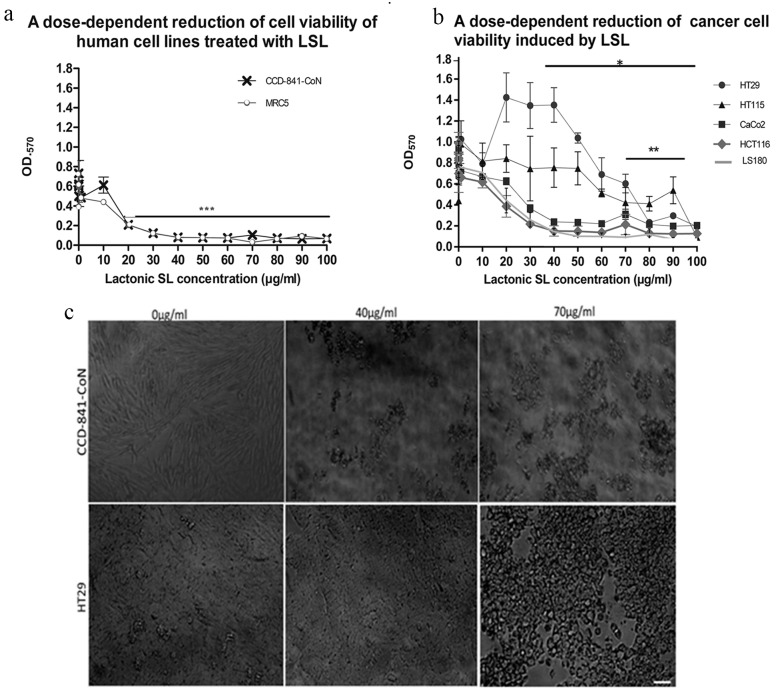
LSL administration causes a dose-dependent effect on cell viability and morphology.(a) Following 24h of treatment with LSL we observed a significant reduction in O.D.570 values at doses between 20–100μg/ml (p<0.0001) in the control cell lines CCD-841-CoN and MRC5. (b) There was a significant reduction in O.D.570 values at doses between 30–100μg/ml in HCT116, Caco2 and LS180 (p < 0.05) and at doses above 60μg/ml inn HT29 and HT115 cells (p < 0.001). Graphs show a representative data set from three independent experimental replicates. Values indicate mean ± SEM (n = 6). Statistical significance was assessed one-way ANOVA (*p < 0.05; **p < 0.001; ***p < 0.0001). (c) Light micrographs from CCD-841-CoN colonic epithelial cells (top) treated with vehicle-only control (left) where cells show a typical bipolar morphology. After treatment with 40μg/ml (central) or 70μg/ml (right) LSL the remaining adherent cells are rounded and there are large regions devoid of cells. In HT29 cultures treated with vehicle-only (bottom right) the cells are densely packed with a cobblestone-like morphology. Following treatment with 40μg/ml LSL (middle), there are no discernable changes in cell morphology, however treatment with 70μg/ml LSL (right) leads to cell rounding and conspicuous cell free areas. Scale bar = 50μm for all images.